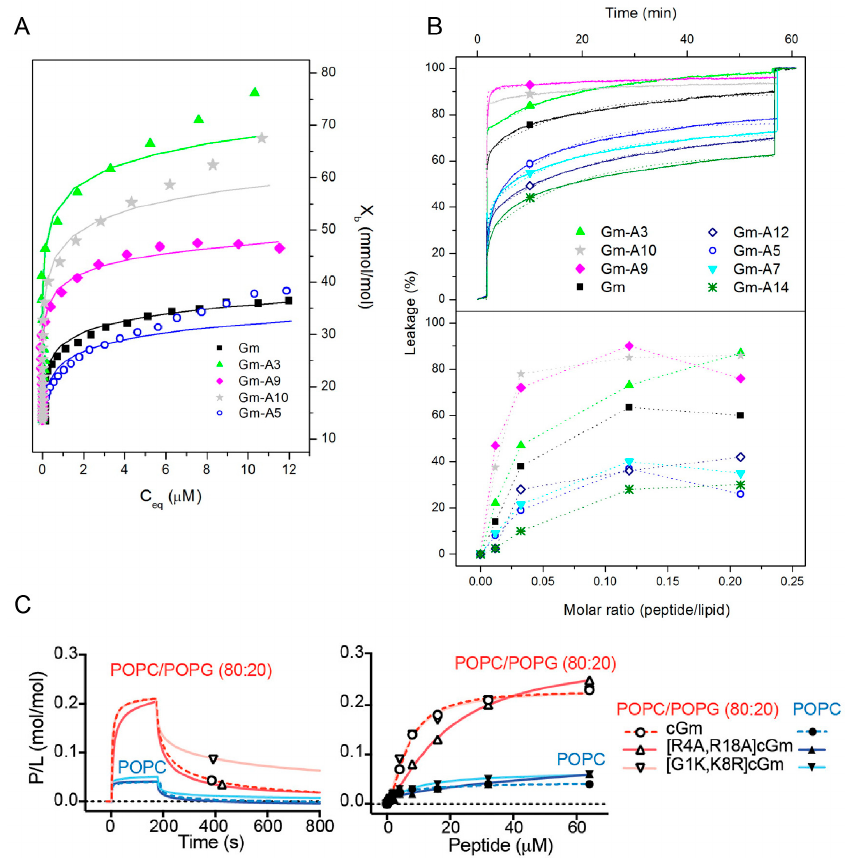
Figure 5. Membrane binding and leakage activity of Gomesin variants. ( A ) Binding isotherms showing molar fraction of bound peptide (Xb) as a function of free peptide concentration (C eq ) obtained from ITC experiments of Gm and its variants binding to LUVs composed of POPC–POPG 7:3 (mol ratio); ( B ) Top panel: Kinetics of CF leakage from LUVs composed of POPC–POPG 7:3 (mol ratio) after addition of Gm and its variants at a peptide-molar ratio of 0.12 at room temperature (~23 °C). Bottom panel: percentage leakage as a function of peptide-lipid molar ratio; ( A , B ) were adapted with permission from Mattei et al. [28]. Copyright 2014 American Chemical Society; ( C ). Binding of cyclic Gm (cGm) and its variants to model membranes composed of POPC and POPC–POPG (4:1 molar ratio) from surface plasmon resonance (SPR) experiments. Left panel: sensorgrams from SPR experiments using a peptide concentration of 32 μ M. Right panel: Dose-response binding curves from the different peptide-lipid concentrations. Response units were converted into moles of peptide and normalised for the amount of peptide. Adapted with permission from Henriques et al. [9]. Copyright 2017 American Chemical